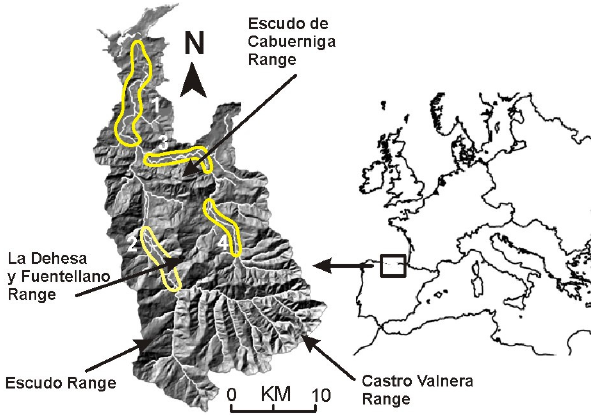
Fig. 1. The study area is the Pas River basin (650km 2 ) located in the northern part of Spain in the Cantabria region. The surface areas of the fluvial landscapes in the valleys outlined in #1–#4 were measured using 2010 Google Earth